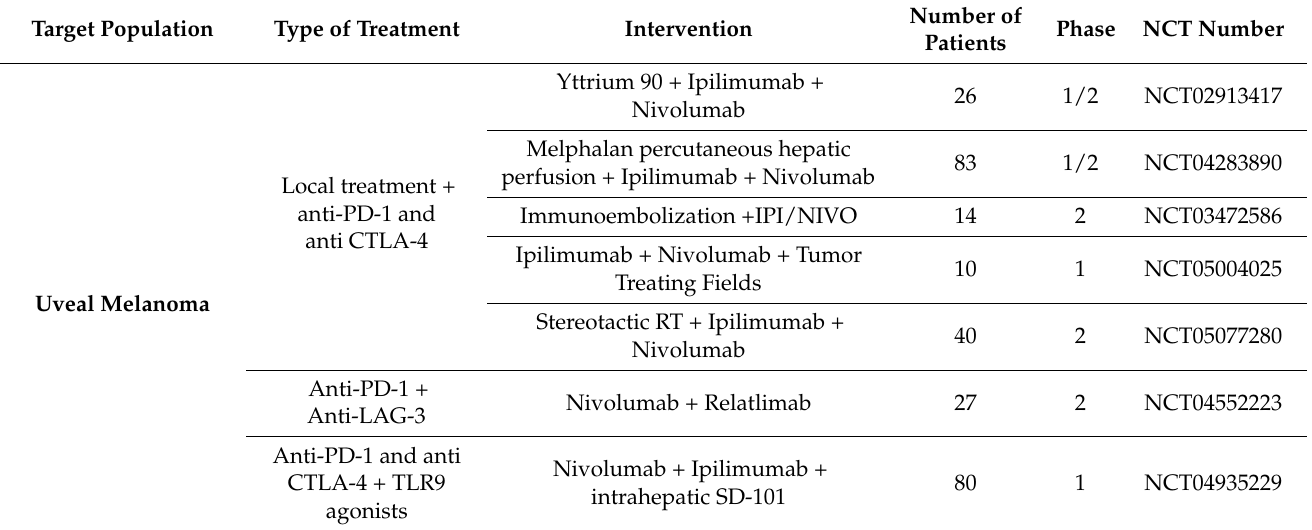
Table 2. Ongoing clinical trial testing immunotherapy strategies in patients with uveal and mucosal melanoma (as assessed on 13 November